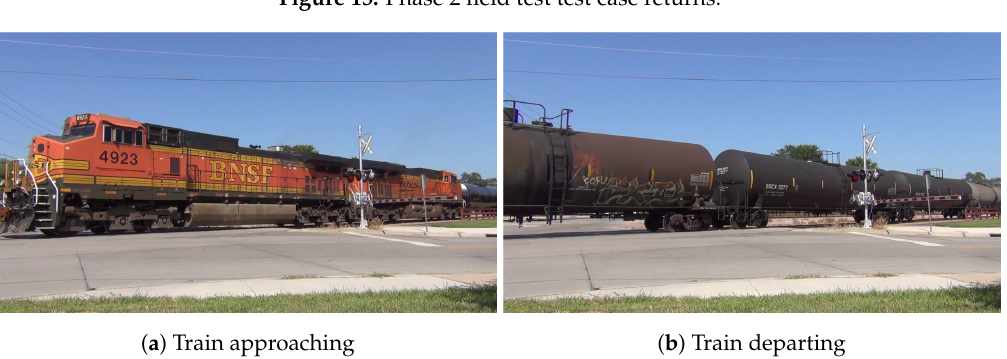
Figure 16. Train studied in the